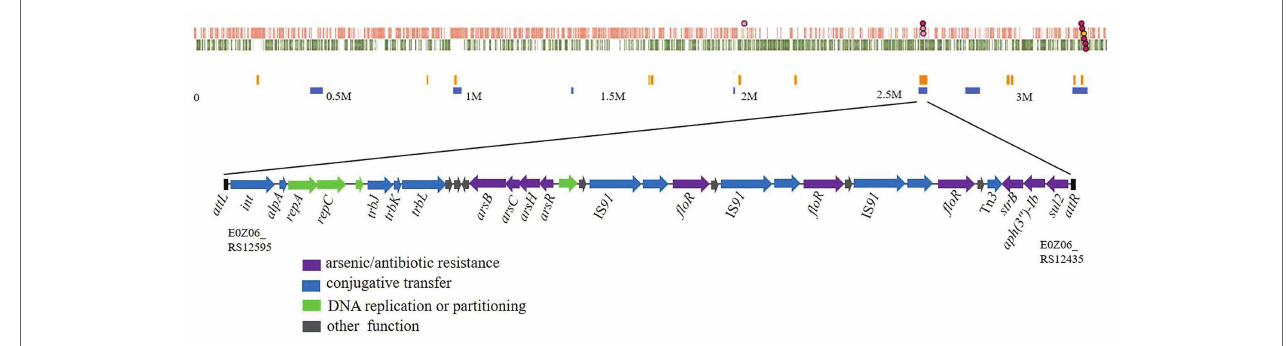
FIGURE 1 | Schematic view of a new identified genomic island (GI) and its position in Rheinheimera sp. D18. Top image, GIs predicted by Island Viewer 4 in Rheinheimera sp. D18. Putative genomic islands were predicted by IslandPath-DIMOB method (blue squares) or SIGI-HMM method (orange squares). Bottom image, gene arrangement in the genomic island named ICE Rsp D18B. ICE Rsp D18B (from E0Z06_RS12595 to E0Z06_RS12435) is bordered by a 20-bp DR (5 ' -ACAATNGAGTGGGAATNNTT-3 ' ) in the chromosome of D18. The diagram shows the predicted classification/function of each gene (represented by arrows) as follows: violet, arsenic, or antibiotic resistance; blue, conjugative transfer; green, DNA replication or partitioning; and gray, other